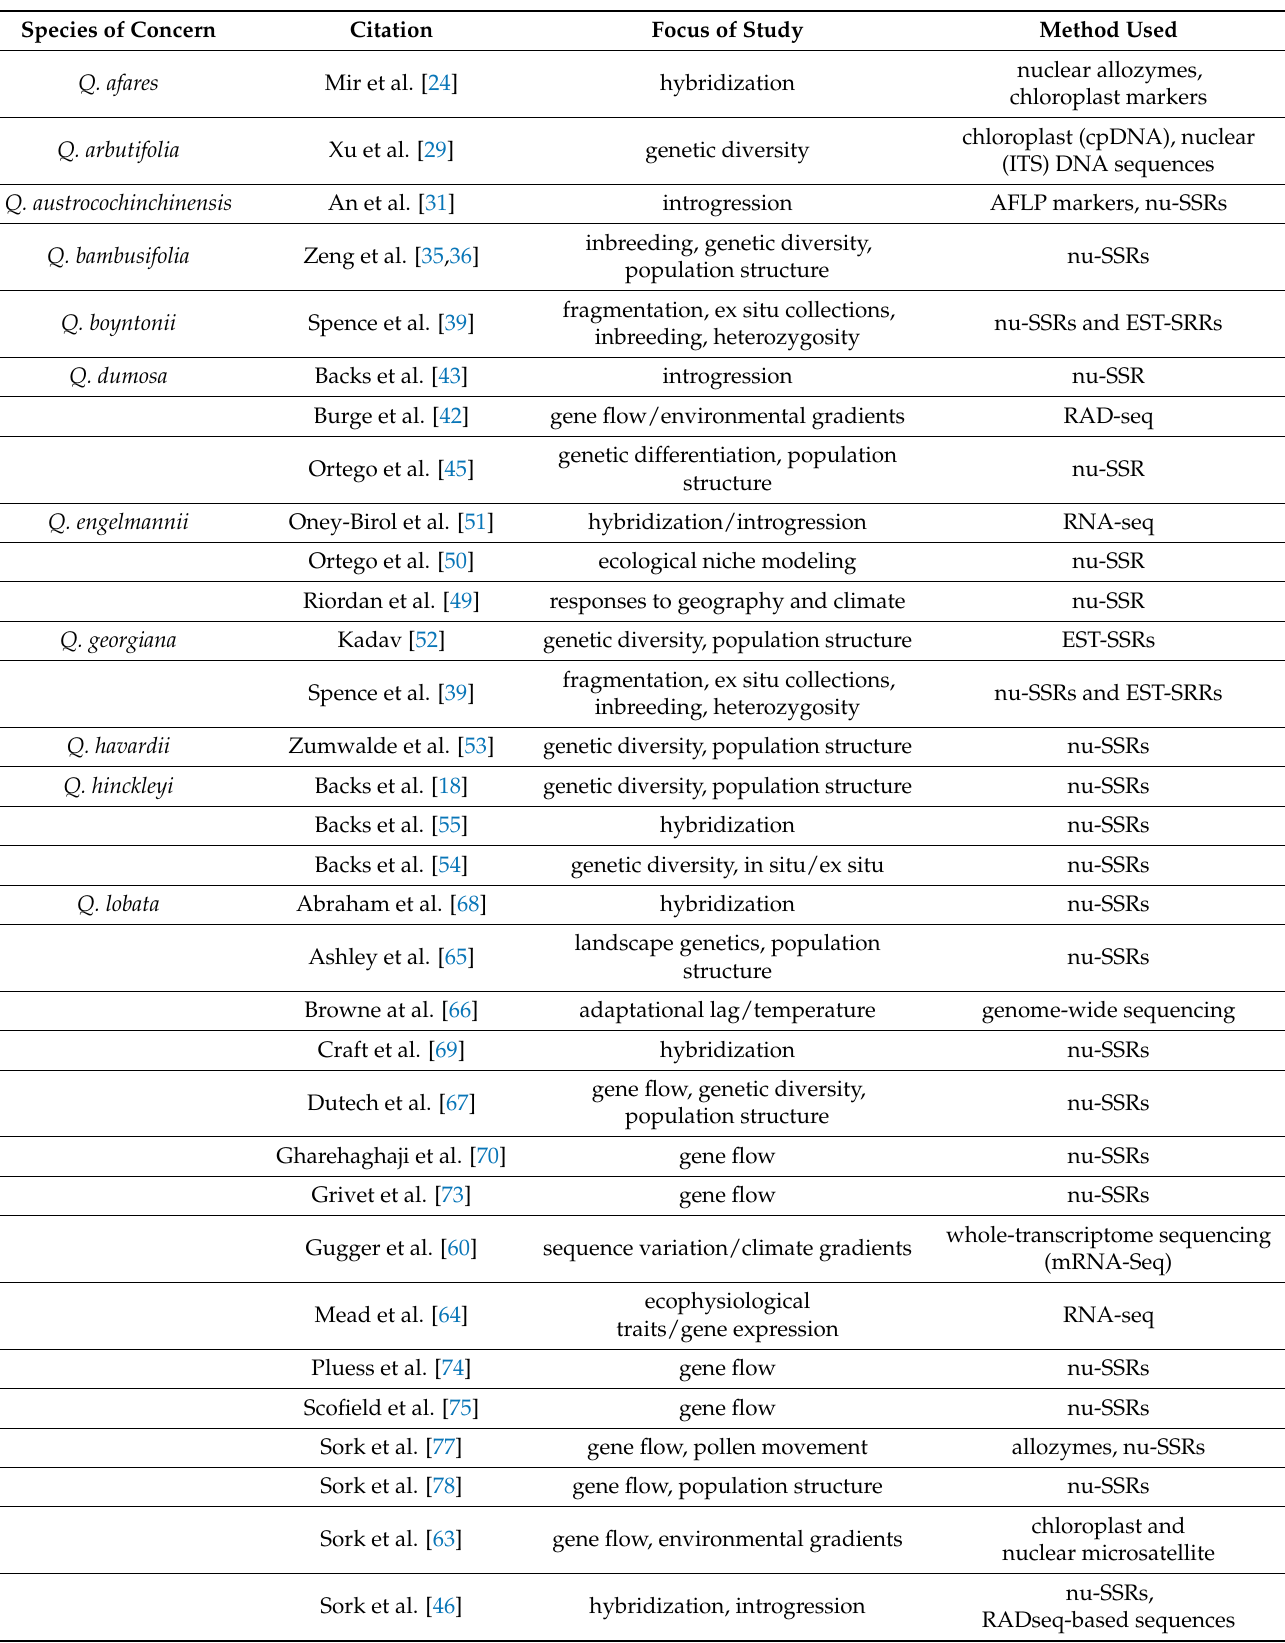
Table 2. Population genetics studies involving Oaks of